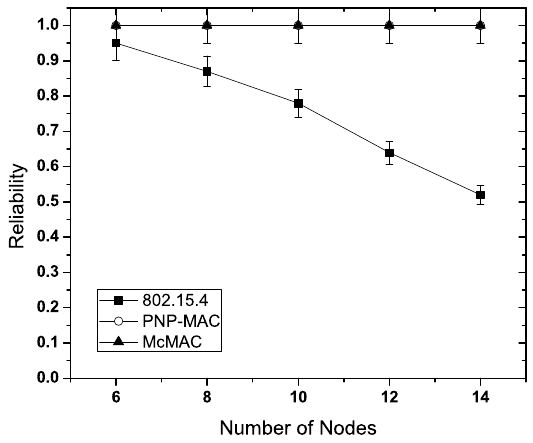
Figure 16. Reliability of emergency packet at varying network size.